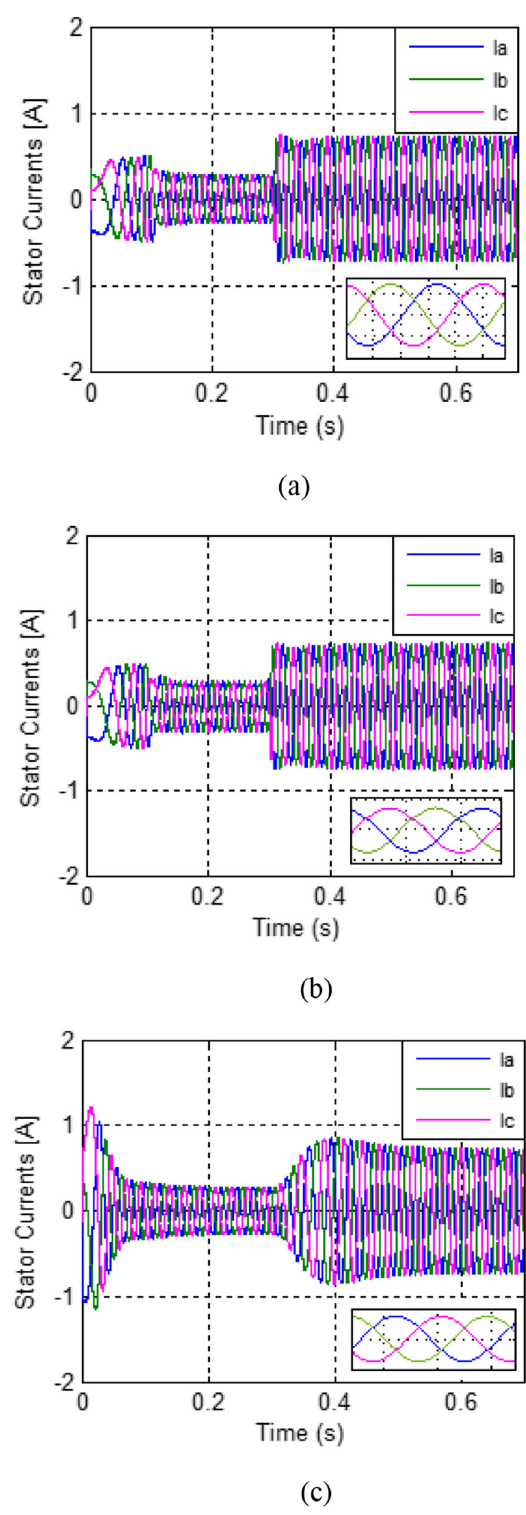
Fig. 8 Electromagnetic torque response (rpm) ( a ) for SM-DTC with a three-level NPC inverter, ( b ) for SM-DTC with a two-level inverter and ( c ) for PI-DTC with a three-level NPC inverter